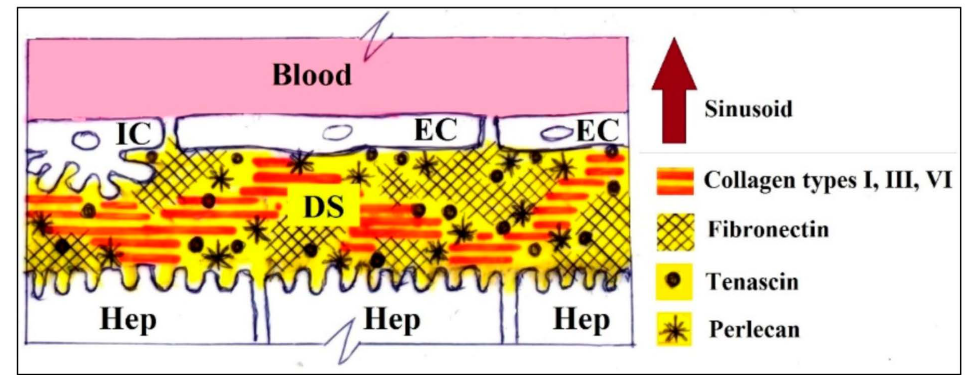
Figure A5. Schematic view of the relationship between sinusoids, Disse’s space, and hepatocytes (the parenchymal compartment of the liver). Note the wall of a sinusoid formed by discontinuous layer of endothelial cells (ECs) and absence of basement membrane underneath the ECs. The Disse’s space (DS; yellow) separates the endothelial cells of sinusoids from hepatocytes (Hep) and stellate cells of Ito (IC). The concentration of fibronectin increases along the sinusoids toward the central veins. Tenascin is relatively rare component. Perlecan is predominantly associated with basement membranes. Laminin is almost absent along the sinusoids in Disse’s space, except the area near the portal triads. The scheme is based on the information from the References [94,101,102,128].